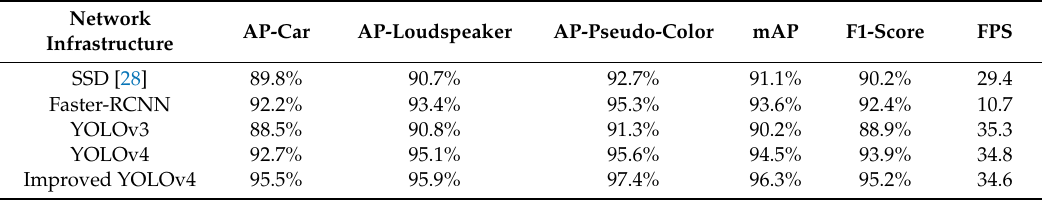
Table 4. Performance comparison of di ff erent network